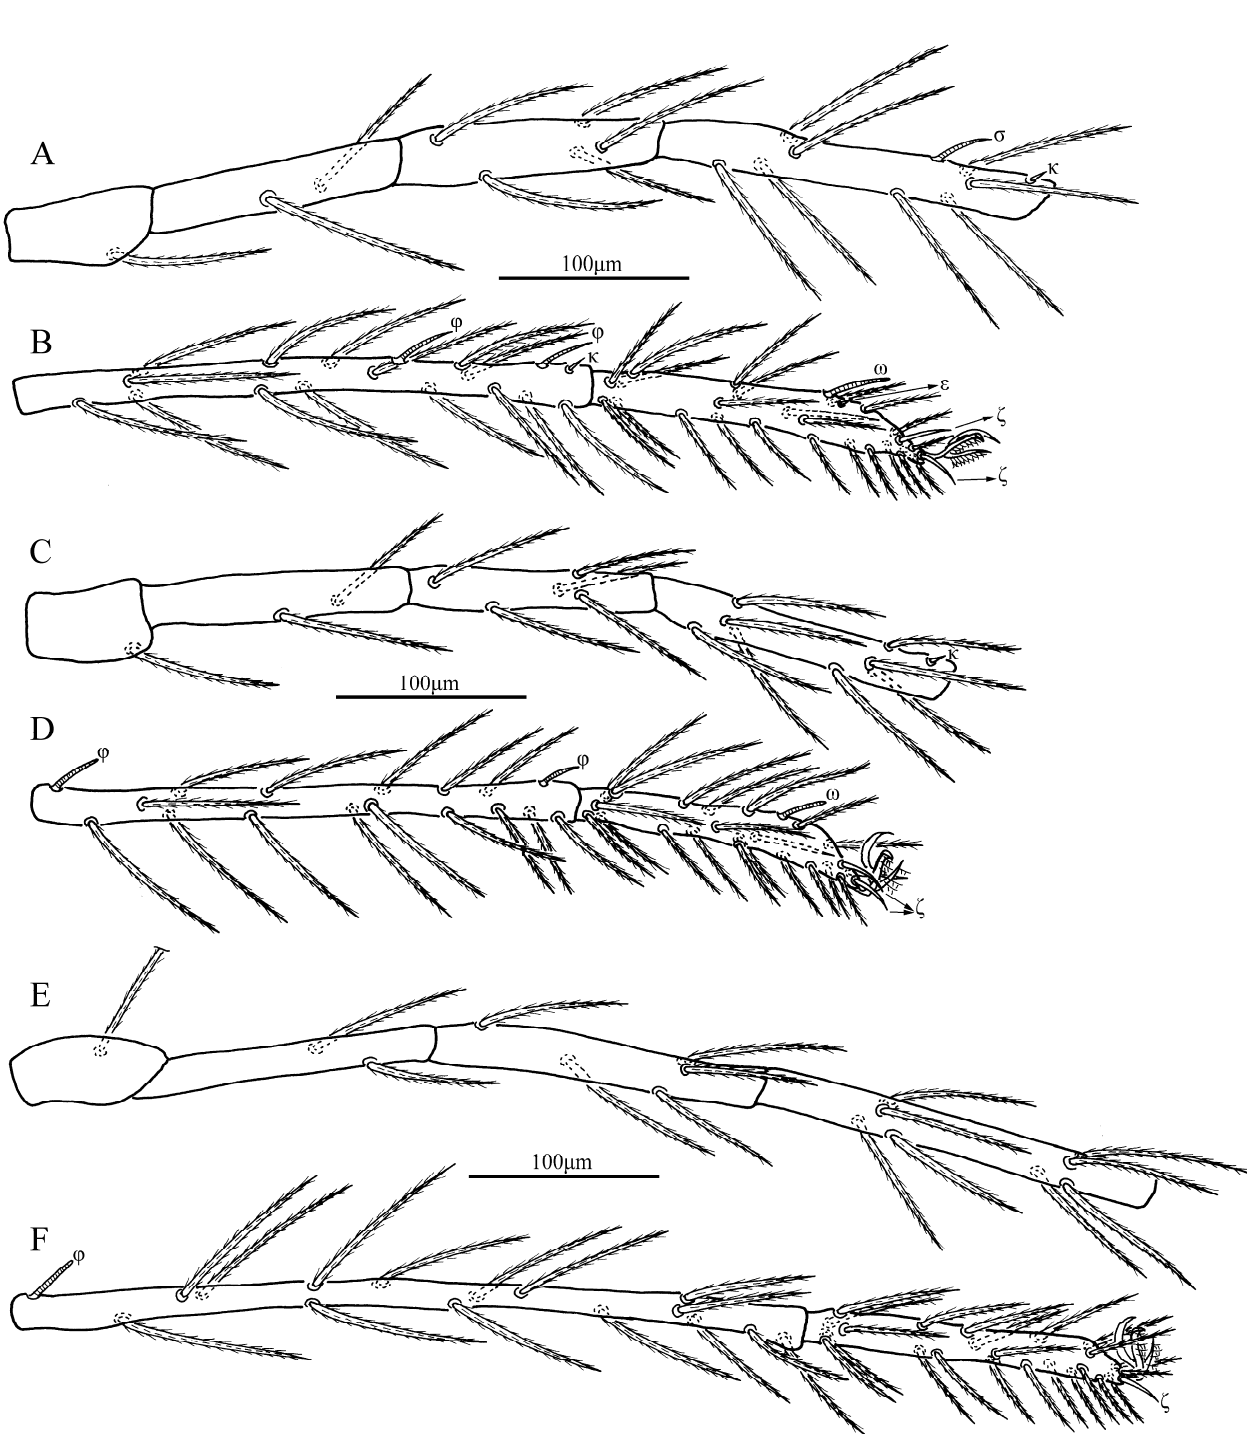
Figure 8. Erythraeus ( Erythraeus ) kunyuensis sp. nov. , larva. ( A ). Leg I, trochanter—genu. ( B ). Leg I, tibia—tarsus. ( C ). Leg II, trochanter—genu. ( D ). Leg II, tibia—tarsus. ( E ). Leg III, trochanter—genu. ( F ). Leg III, tibia—tarsus.